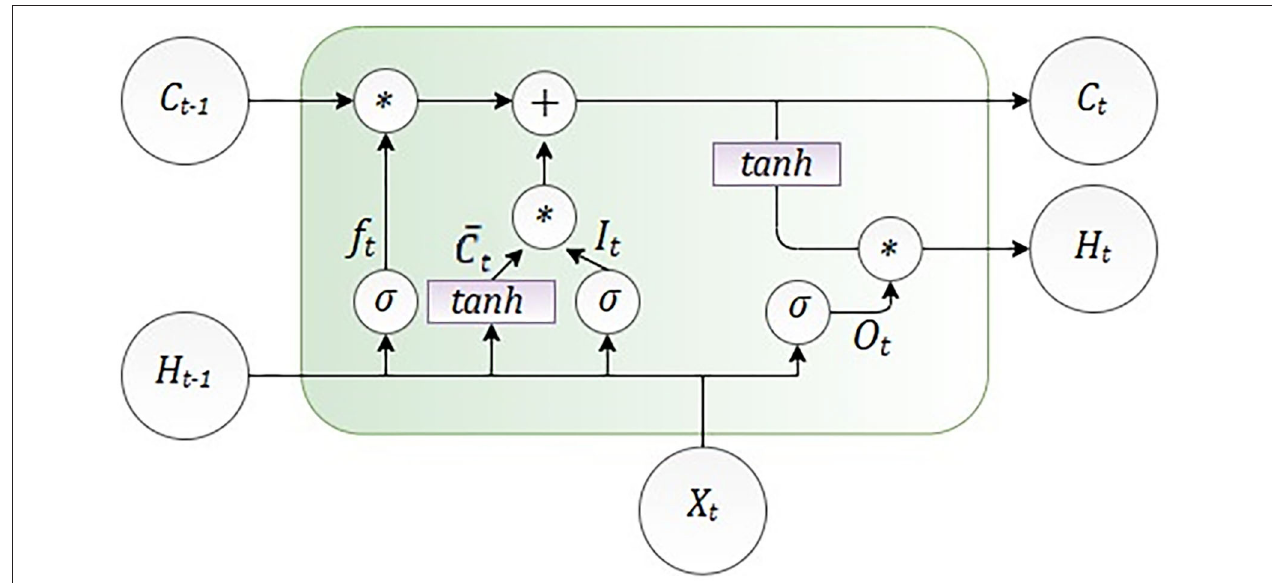
FIGURE 2 | Architecture of one long short-term memory (LSTM)